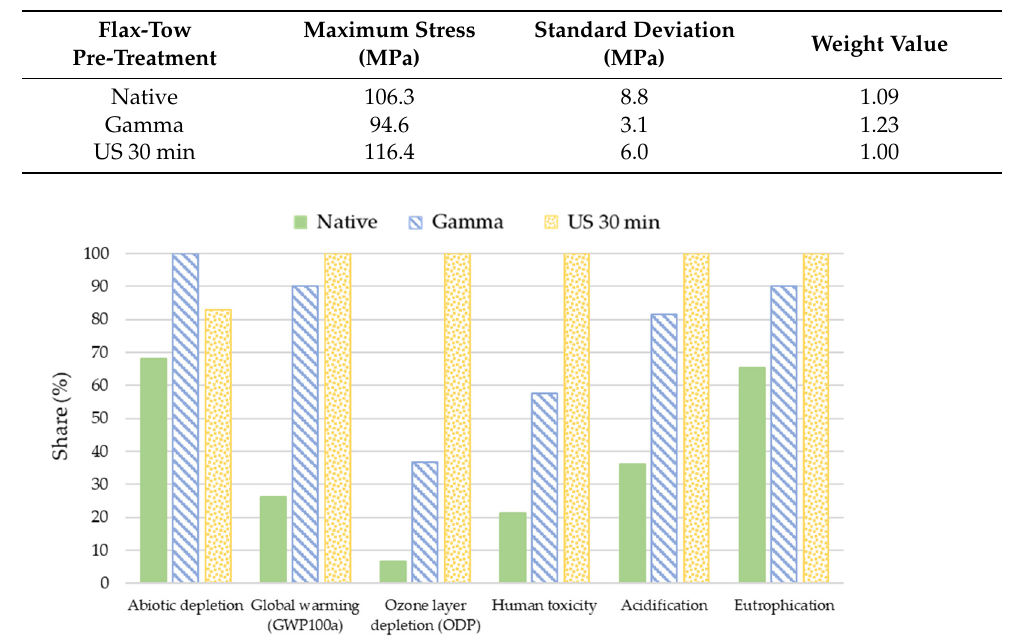
Figure 14. Normalised comparison of scutching native flax tows, flax tows pre-treated by Gamma and US 30 min for six impact indicators—weighted by the experimental maximum stress values obtained for the PLA composite reinforced by respective flax-tows. Table 5. Maximum stress values of PLA composite reinforced by respective flax-tows and corre- sponding weight values of scutching native and pre-treated flax tows by Gamma and US 30 min.